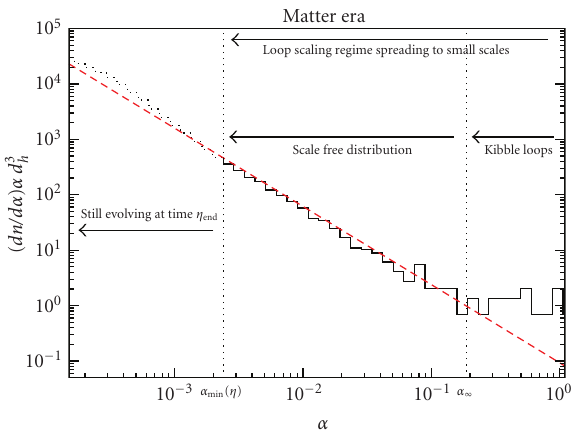
Figure 9: Loop number density distribution at the end of a (100 (cid:15) c ) 3 matter era numerical simulation. Apart for a few Kibble loops ( α ∞ < α < 1), all loops of size (cid:15) = αd h with α > α min follow a scaling regime in which their number density is a power law. Smaller loops are still in the relaxation regime and will enter their scaling regime later (see Figure 10). The red dashed line if the best power law fit of the scaling function S ( α ) is given by